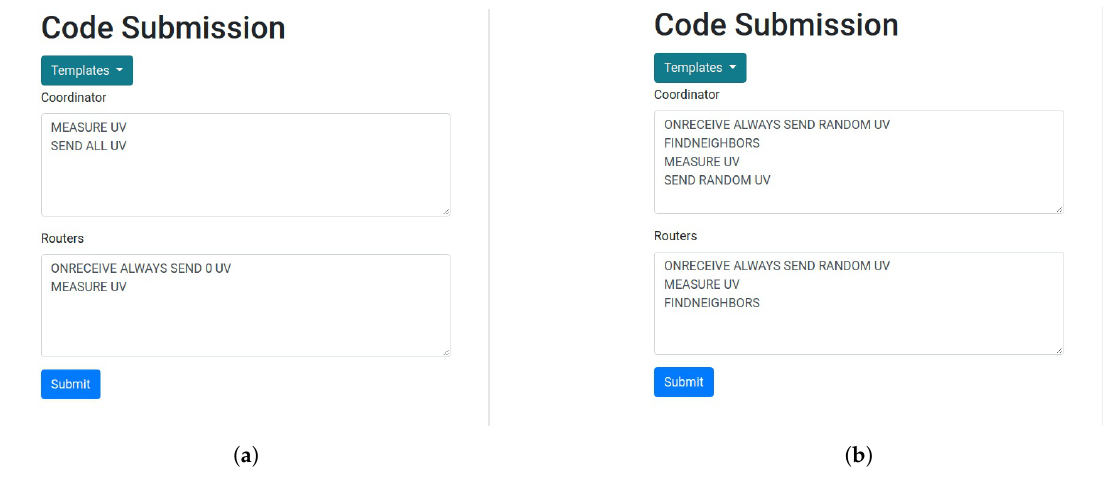
Figure 5. Execution of two programs developed in the custom designed language: ( a ) the Echo algorithm; ( b ) deployment of a single random